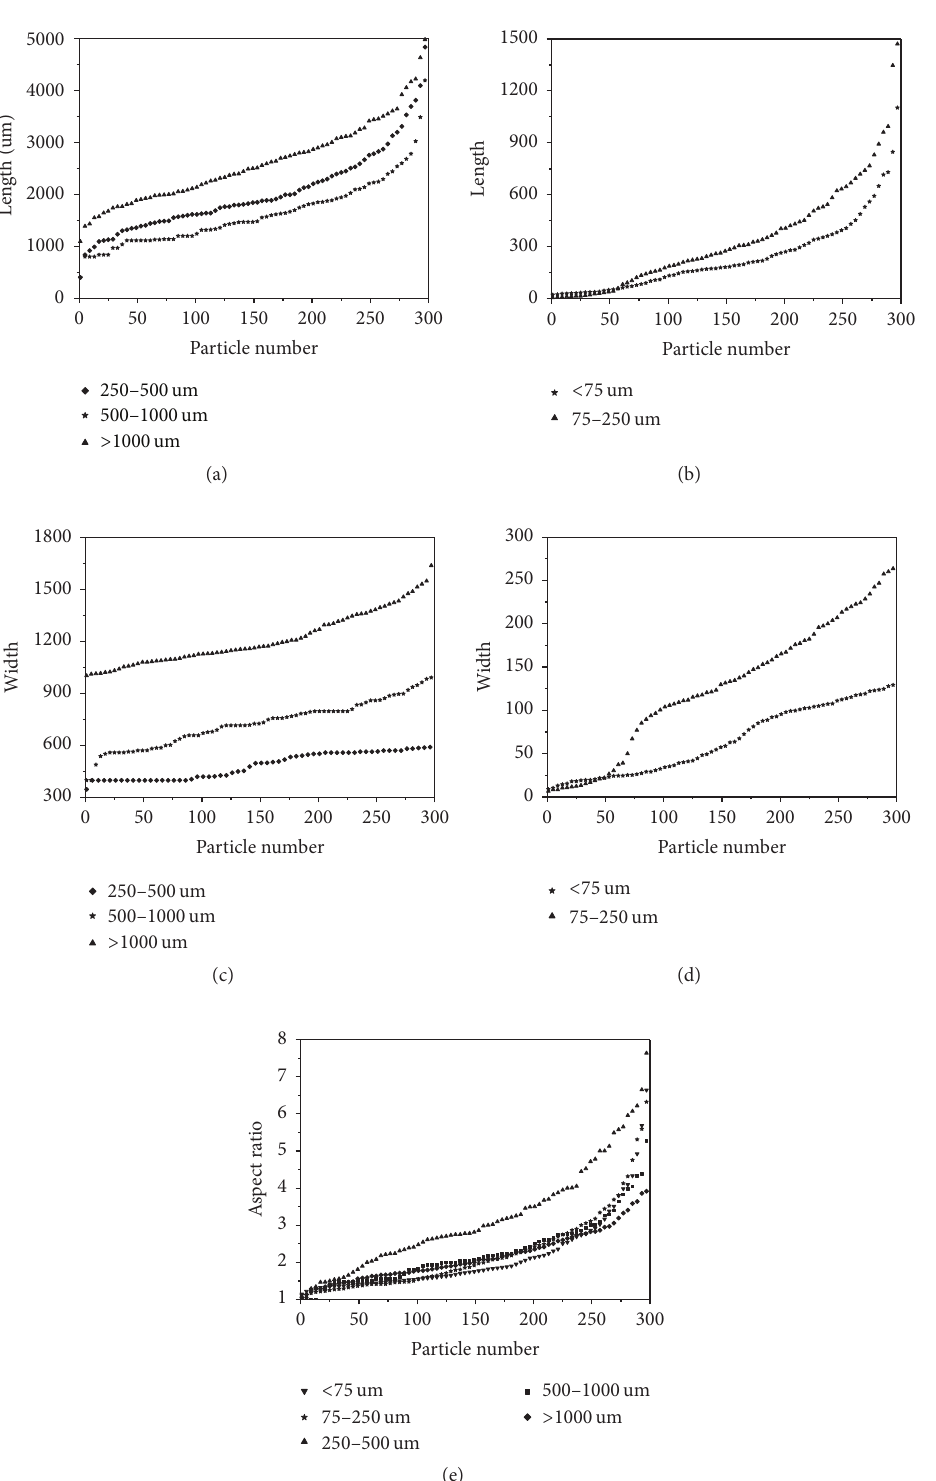
Figure 6: Particle size and shape distribution of ground wheat straw powders. (a) Distribution curves of lengths larger than nominal 250 𝜇 m, (b) distribution curves of lengths less than nominal 250 𝜇 m, (c) distribution curves of widths larger than nominal 250 𝜇 m, (d) distribution curves of widths less than nominal 250 𝜇 m, and (e) distribution curves of